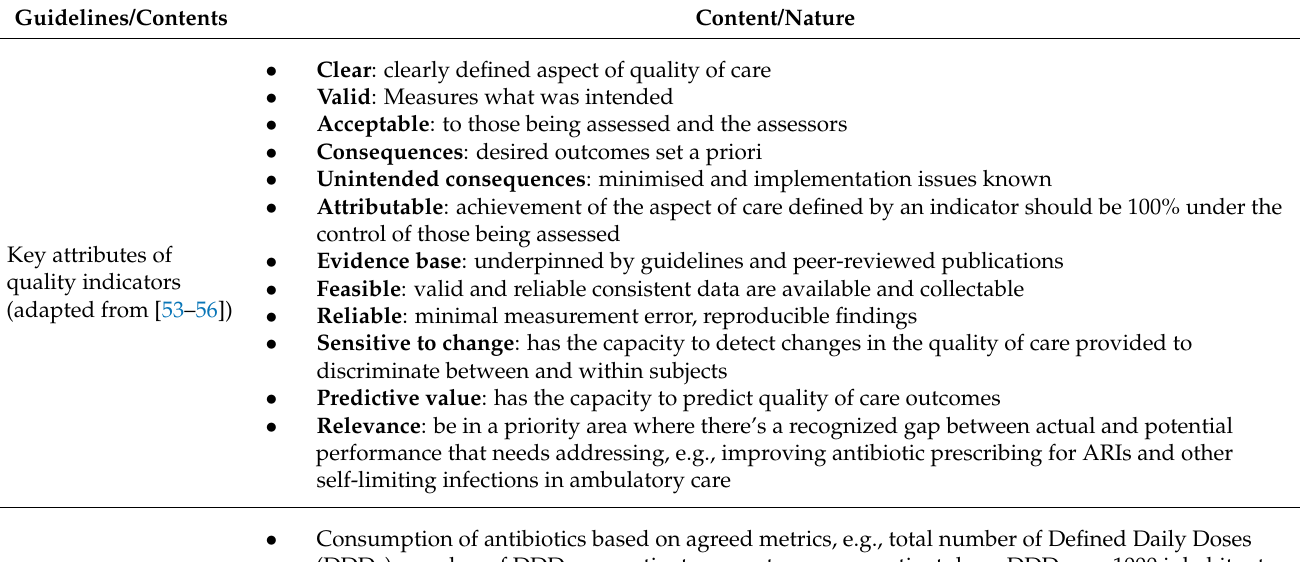
Table 1. Indicators used across countries to improve the prescribing of antibiotics in ambulatory